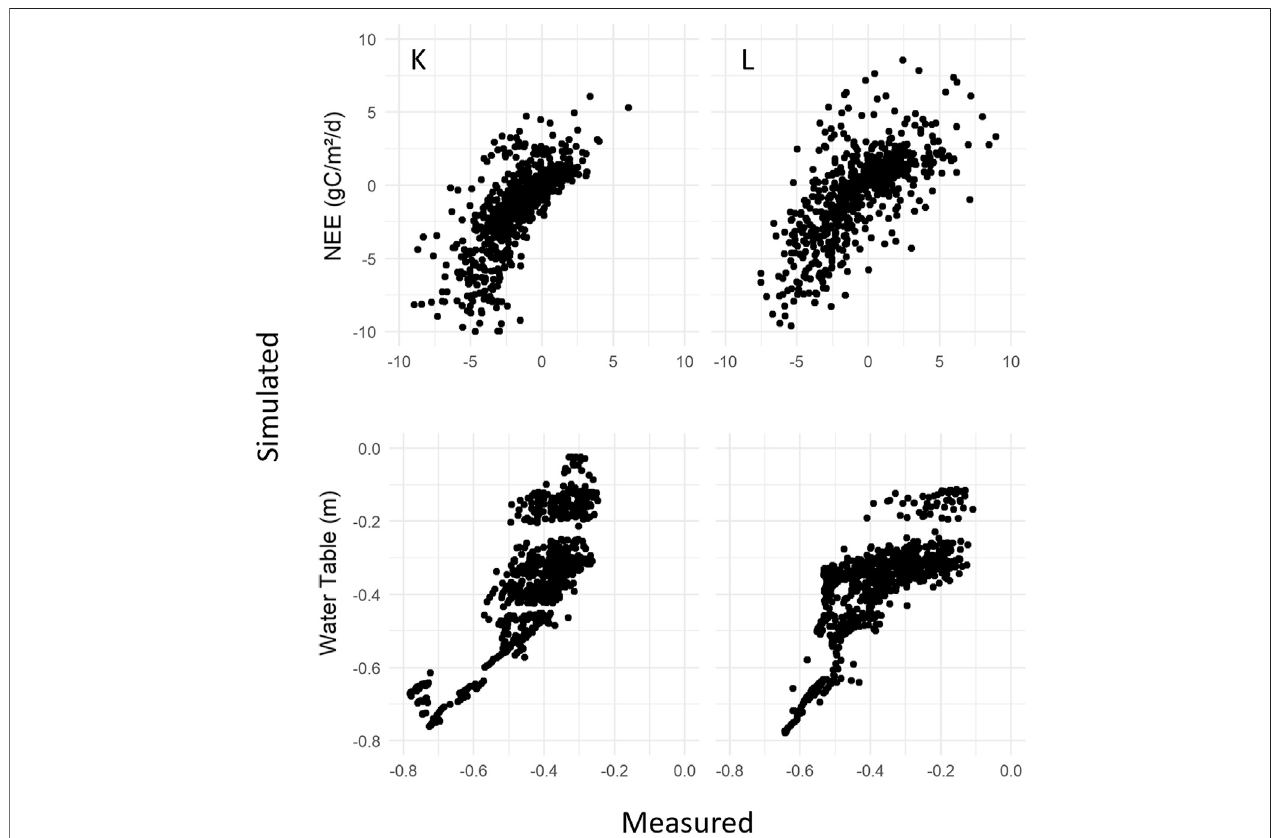
FIGURE5| 1:1plotsofdailymeasuredvs.simulatedaverageNEE,g C m − 2 day − 1 andWT,m.OntheleftmeasuredKalevansuodatatogetherwithsimulatedK.On the right Lettosuo and L